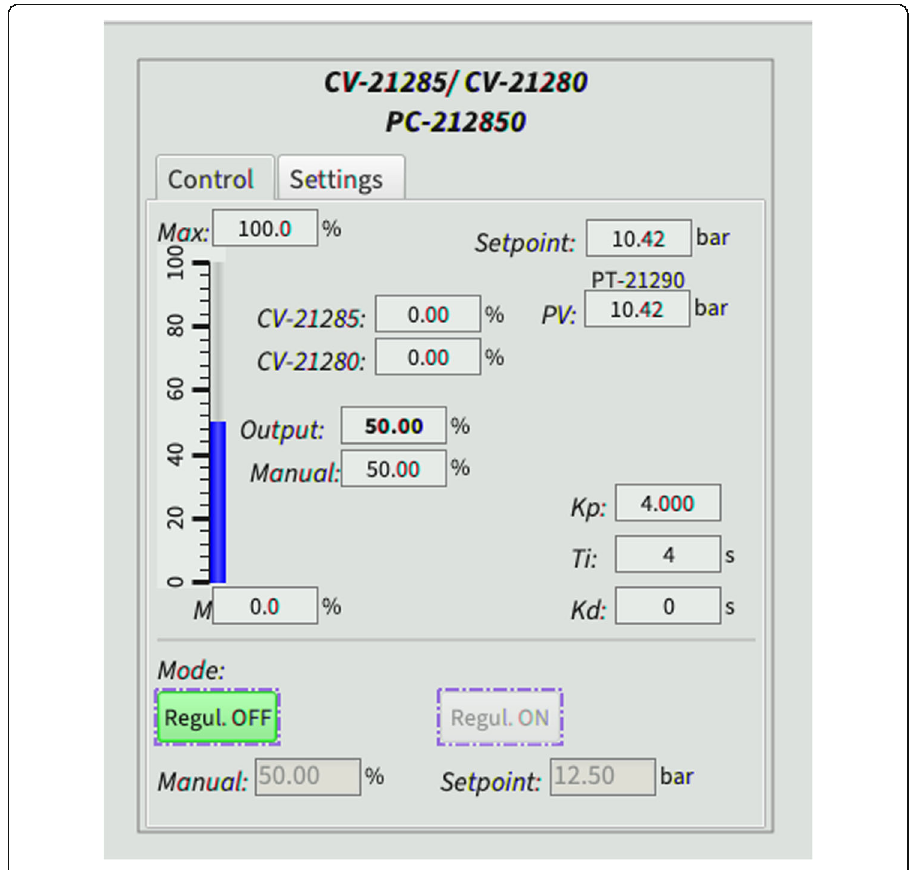
Fig. 9 Controller faceplate TICP